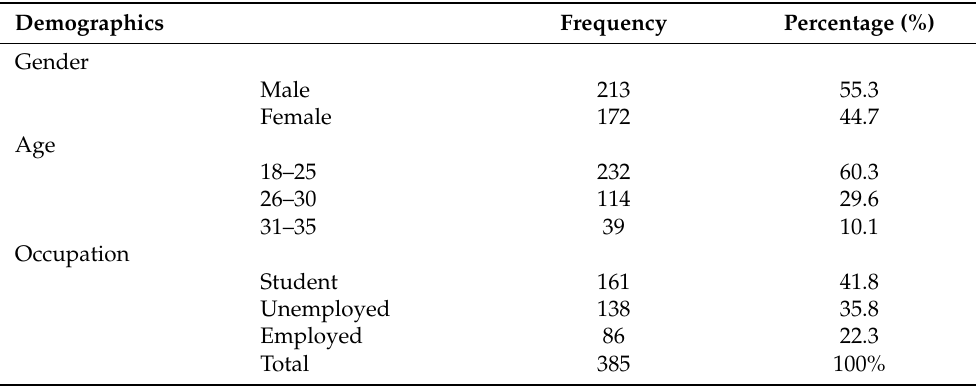
Table 1. Respondents’ demographic characteristics.